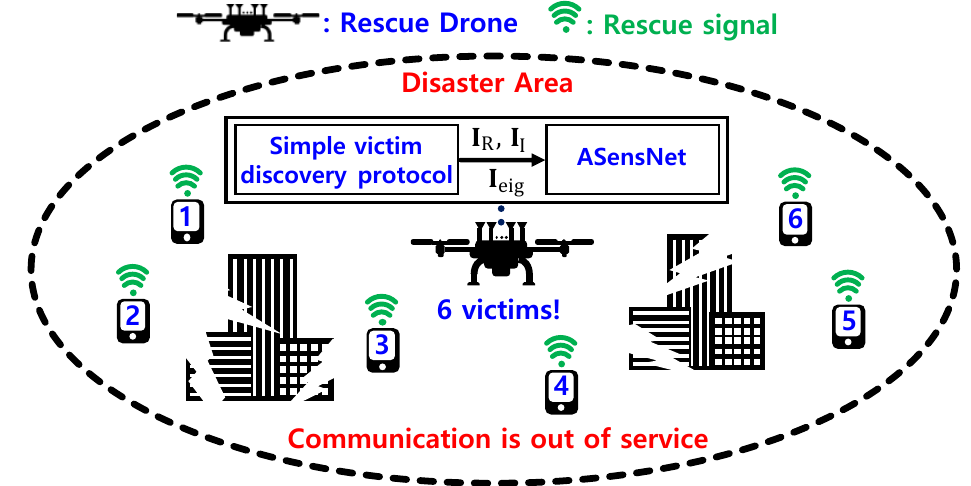
Figure 3. Disaster scenario in which all cell sites are destroyed by a natural disaster.